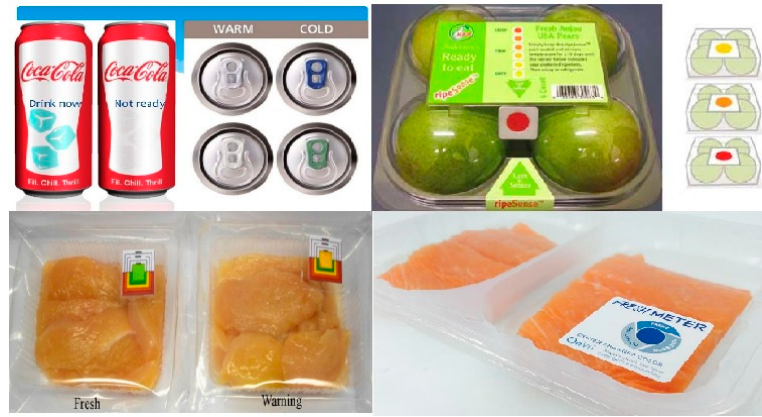
Figure 3. Some examples of intelligent bio-based food packaging.